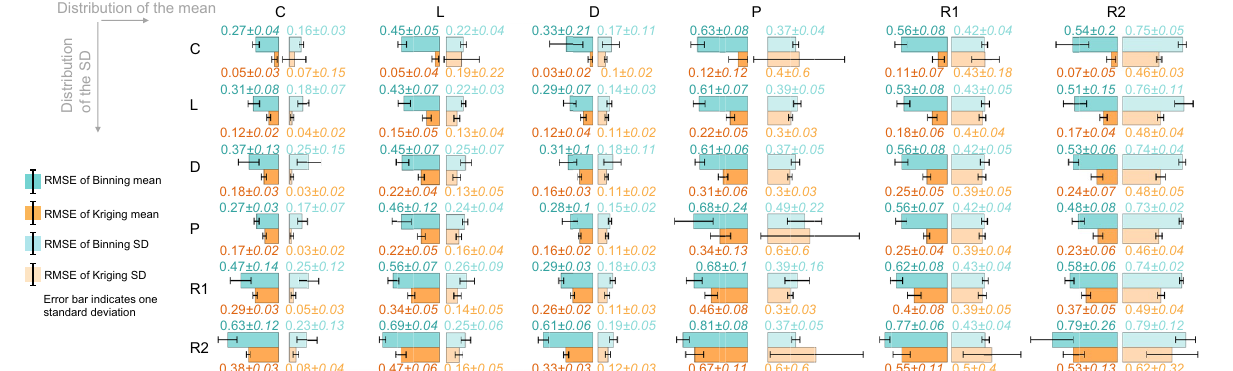
Figure 5. Comparison of mean and SD prediction results for the 36 synthetic models. The Kriging interpolation for the mean is consistently better than binning approach. # Points = 2000, # G bins = 30, # ΔG bins = 40, # of iterations = 20.